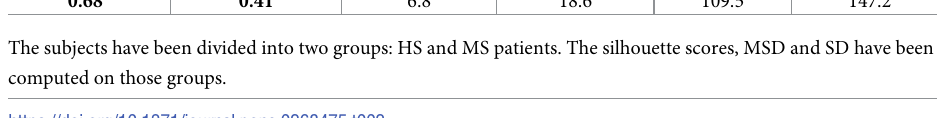
scores, and the third one studies the evolution of each subject between M0 and M6. Each experiment corresponds to a different partition of the database.